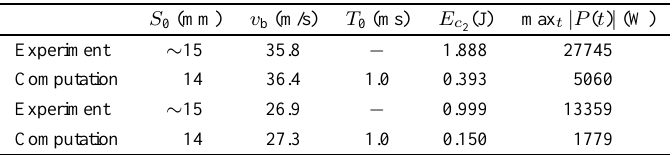
Values of injury criteria for softball impact to the side of the head